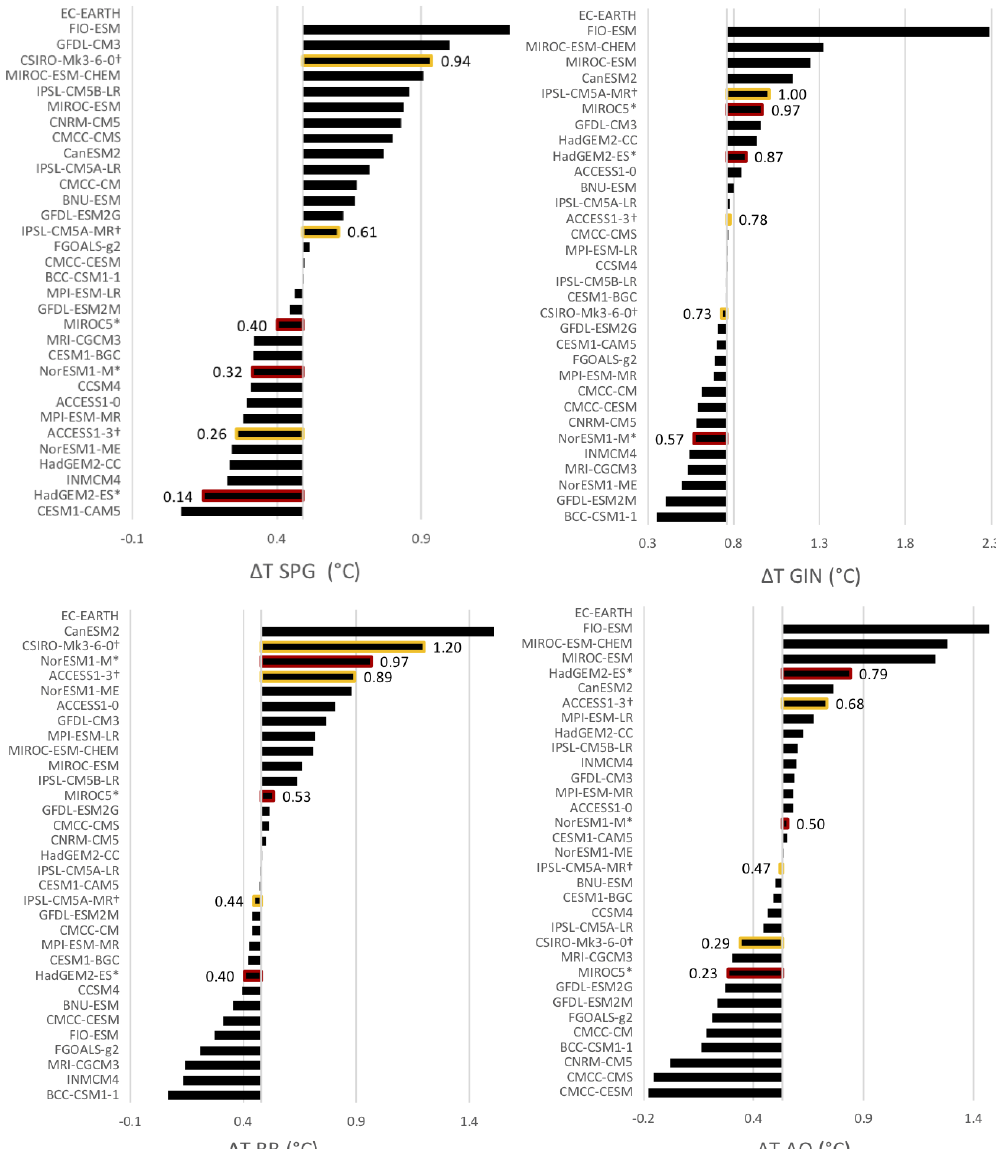
Figure B2. Projected RCP8.5 warming for each CMIP5 model between 1980–2000 and 2080–2100 in the four Greenland shelf regions (SPG: Subpolar Gyre; GIN: Greenland–Iceland–Norwegian seas; BB: Baffin Bay; AO: Arctic Ocean). The symbols * and † identify models selected in the top three and top six ensembles,